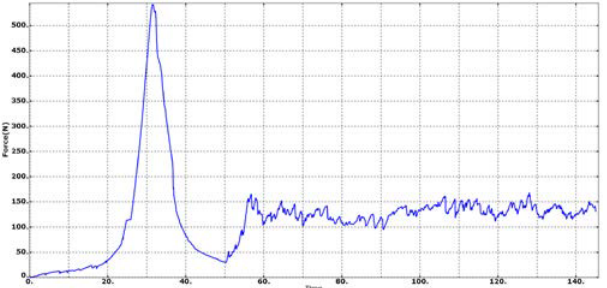
Fig. 8. Roller peeling sample test curve (The average load of the curve is taken in the middle of 60-